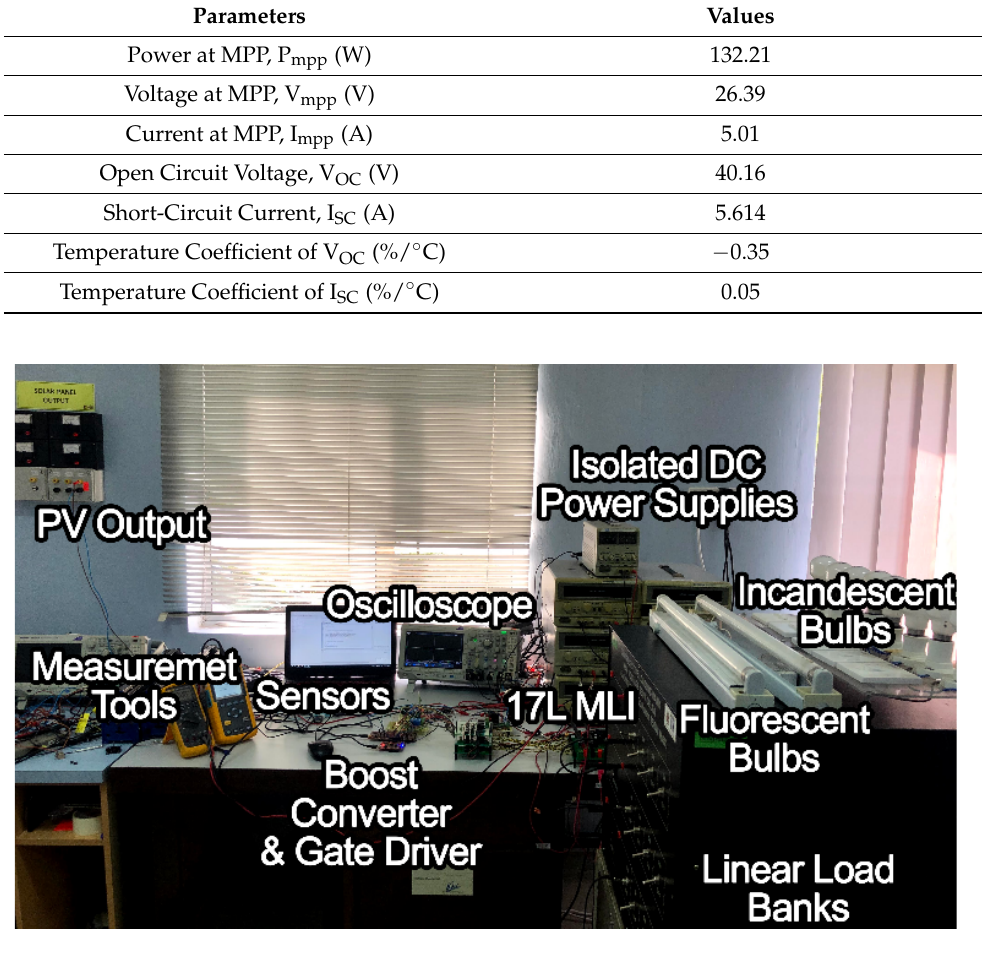
Figure 7. Experimental setup. Table 3. PV panel characteristics at